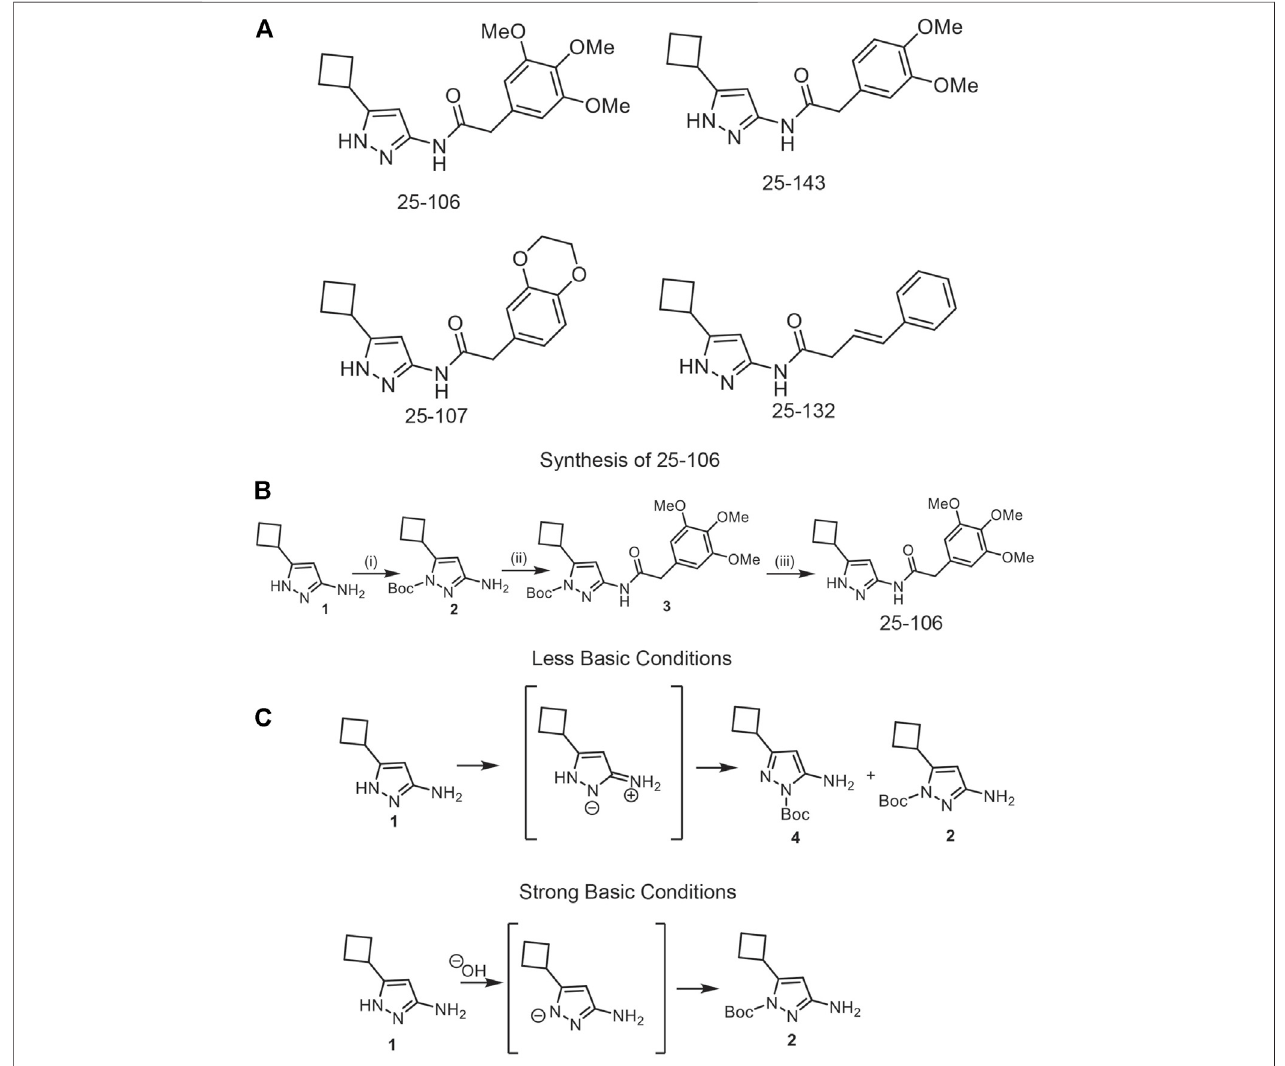
FIGURE 1 | Development of new Cdk5 inhibitors. (A) Structures of four potential Cdk5 inhibitors: 25 – 106, 25 – 143, 25 – 107, and 25 – 132 (B) . Synthesis of novel inhibitor, 25 – 106 (C) . Regio-isomers are synthesized under strong or less basic conditions.